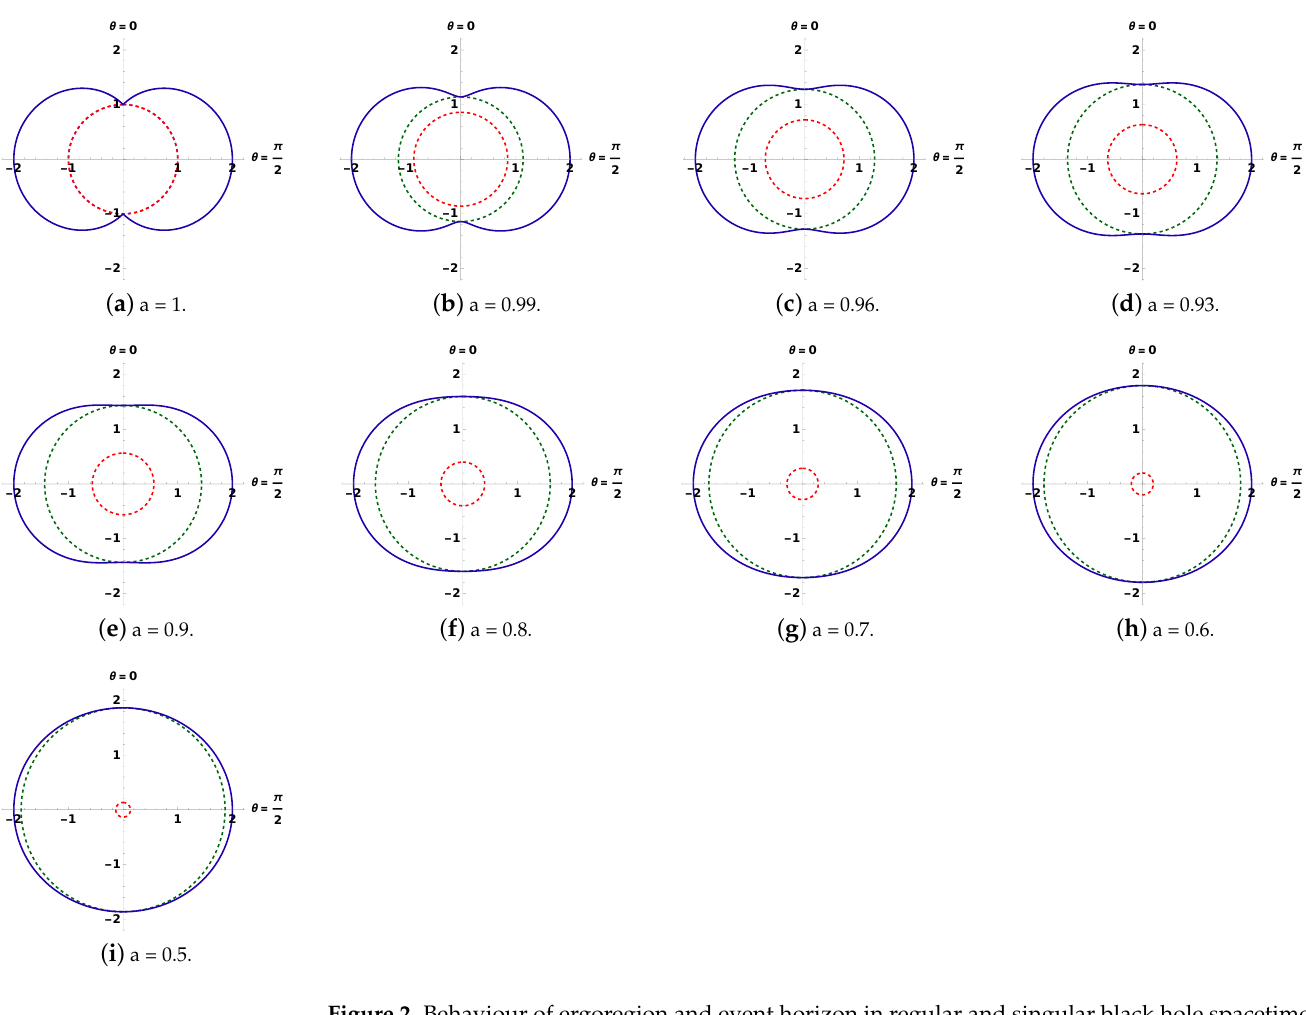
Figure 2. Behaviour of ergoregion and event horizon in regular and singular black hole spacetime with different parameters. The blue circle is for the outer boundary of the ergoregion, and the dotted green and red circles represent the outer and inner horizons, respectively. The mass is set equal to one for all the different